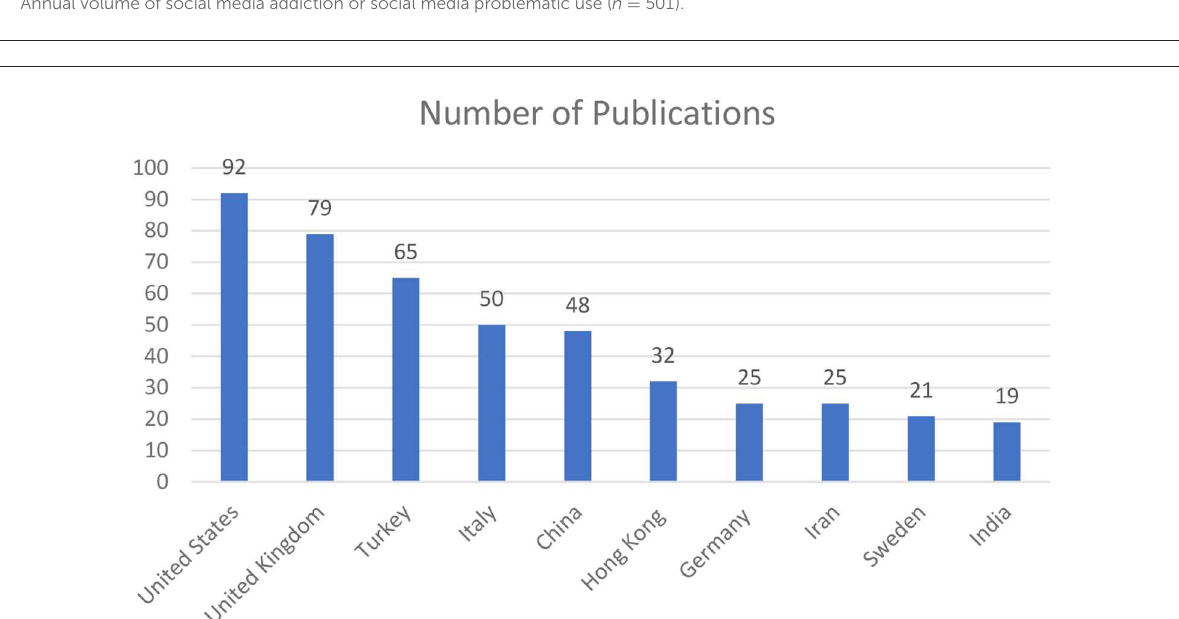
FIGURE3 Global dispersion of social networking sites in relation to social media addiction or social media problematic use.